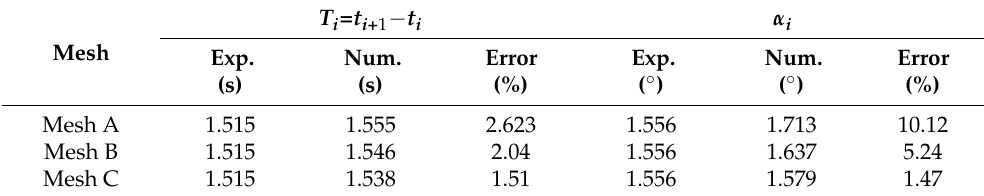
Figure 8. The roll decay motion of the damaged ship, obtained by the experiment and the numerical simulations using different meshes. Table 3. Roll nature periods and roll peak obtained by the different meshes at the ninth cycle of the roll decay for the damaged